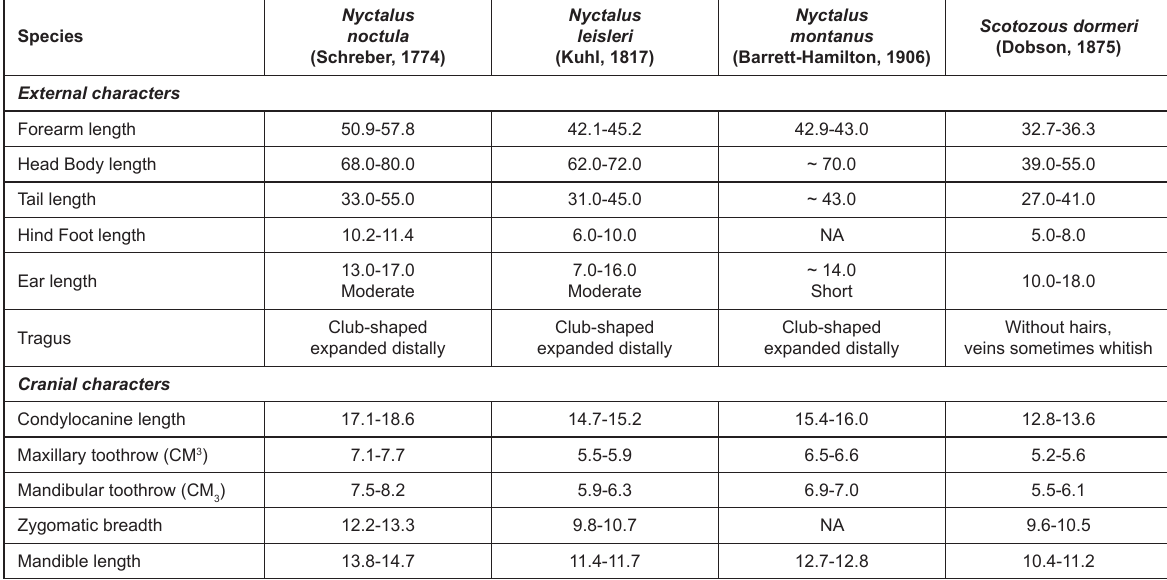
Table 7.7. Diagnostic morphological characters of the species belonging to the genera Nyctalus and Scotozous present in South asia